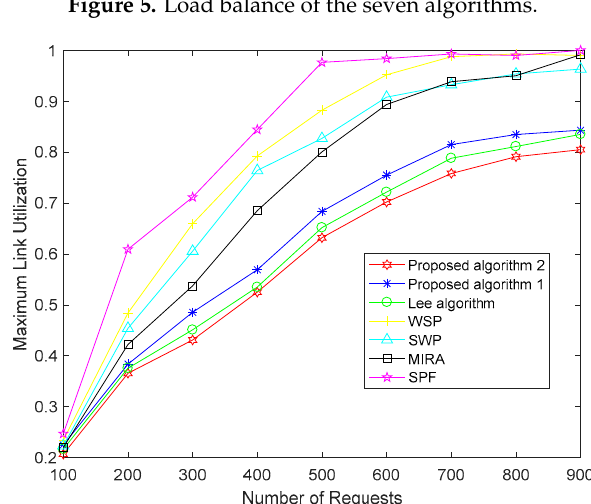
Figure 6. Maximum link utilization of the seven algorithms.